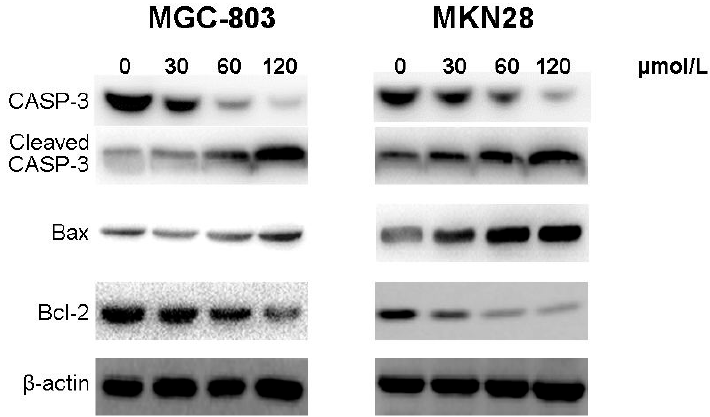
Figure 5. CVB-D induces expression of apoptosis-related proteins in MGC-803 and MKN28 cells. The protein bands of cleaved Caspase-3, Bax and Bcl-2 were detected using western blotting in CVB-D (0, 30, 60 and 120 µmol/L) treated MGC-803 ( left ); and MKN28 cells ( right ). β -actin was used as the control protein.